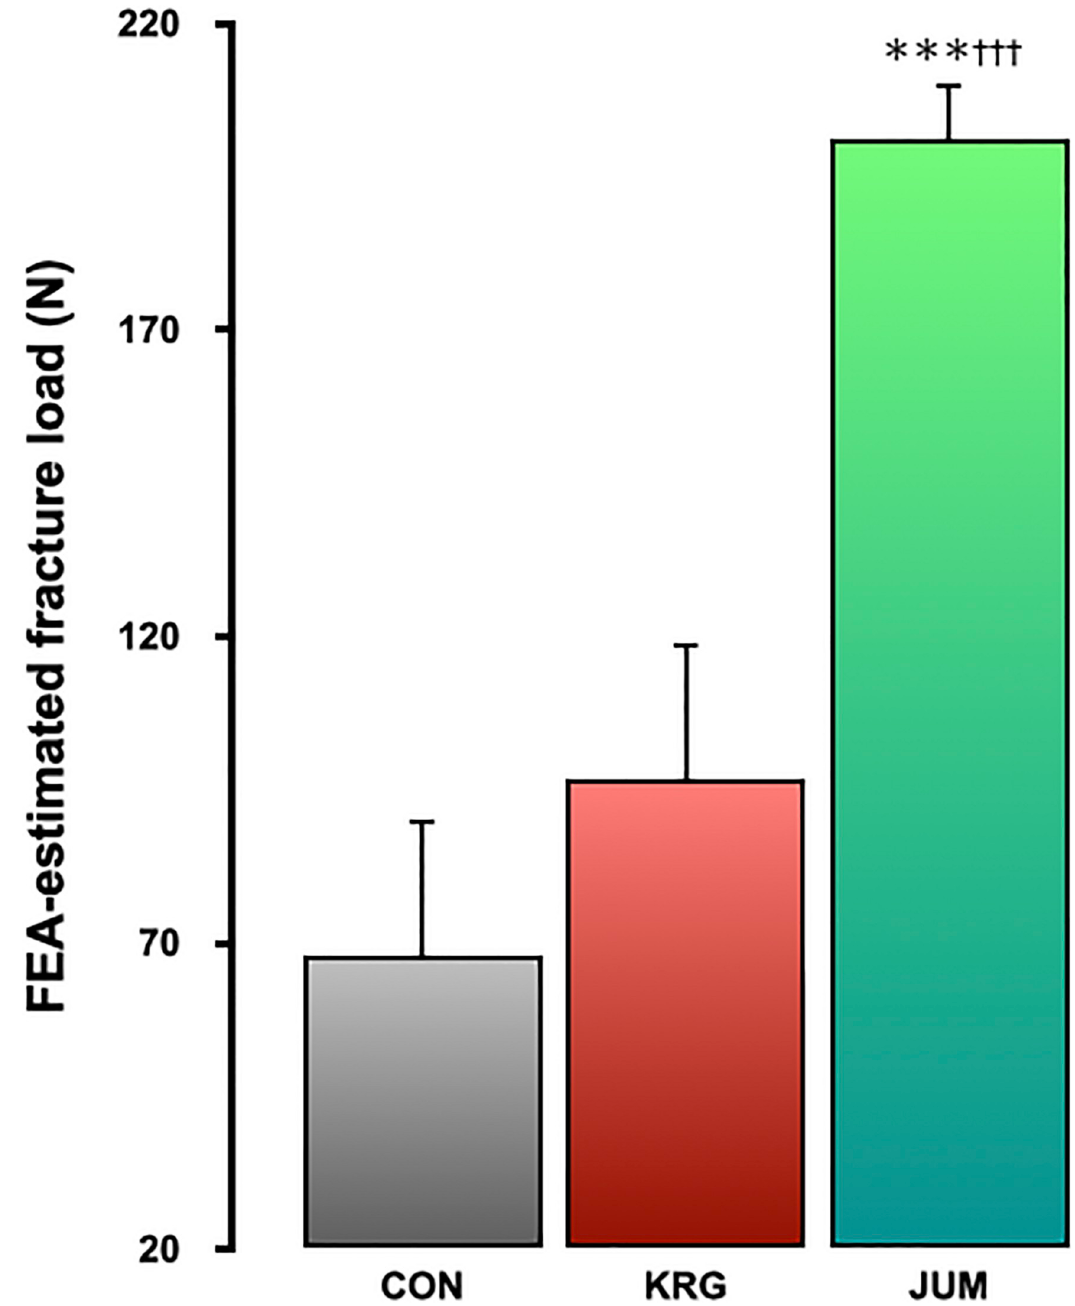
Fig 3. Fracture load as predicted by FEA. CON, sedentary control group; KRG, KRG administration group; JUM, jump exercise group. All data represent mean ± SD. Significant difference vs. CON group: ��� p < 0.001. Significant difference vs. KRG group: ††† p <